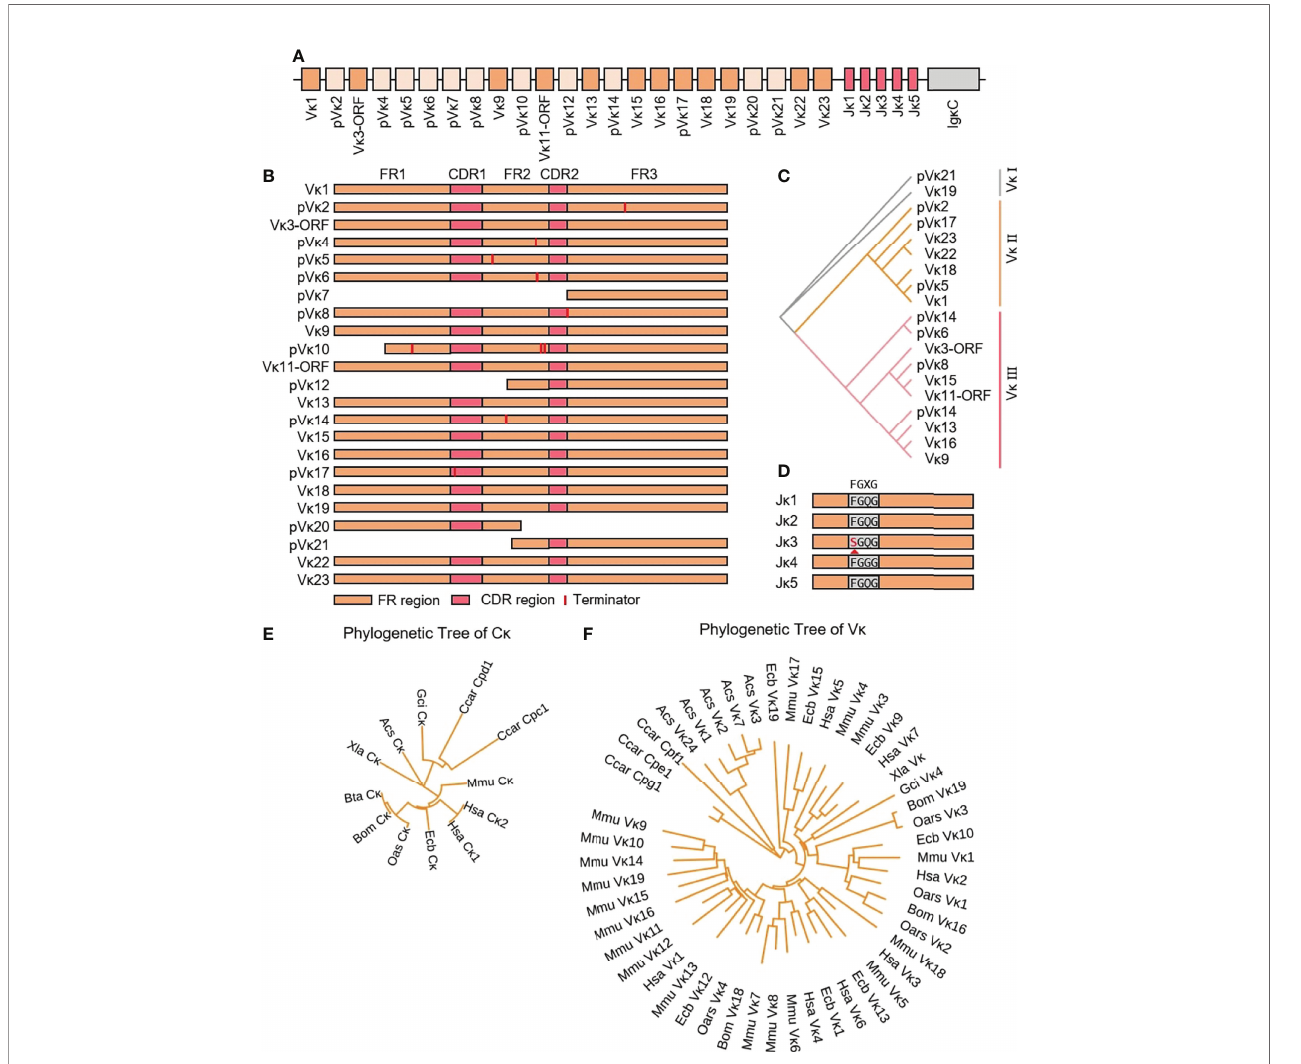
FIGURE 5 | Schematic structure of the genomic organization of Yak IgL( k ) and its relatedness with representative vertebrate species. (A) : Schematic structure of the genomic organization of Yak IgL( k ); (B) The structural variation of Yak V k ; (C) The phylogenetic tree of yak V k ; (D) The structural variation of Yak J k ; (E) The phylogenetic tree of k in yak and representative vertebrate species; (F) The phylogenetic tree of different V k gene family between yak and representative vertebrate